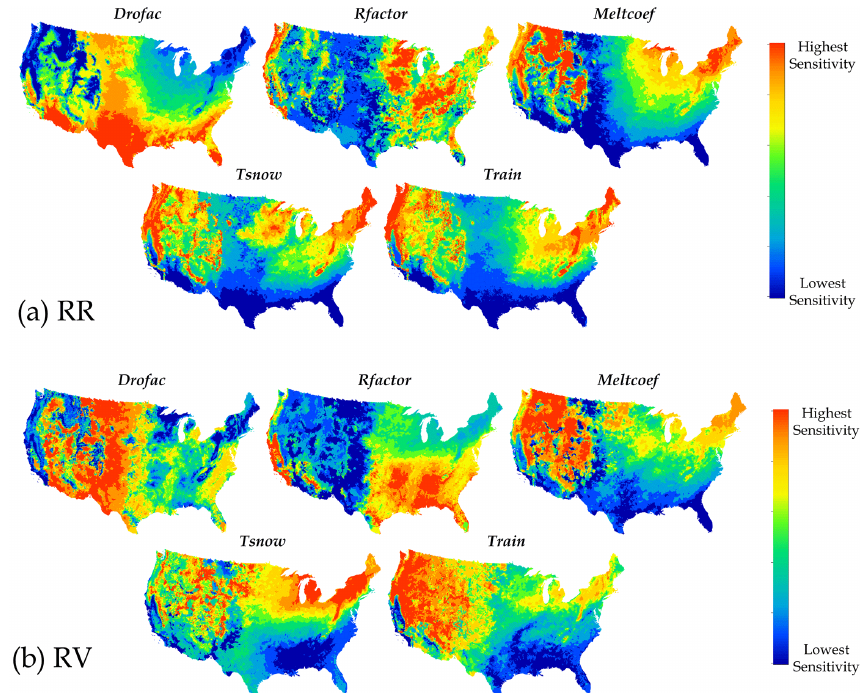
Figure 4. Relative sensitivity of the (a) rainfall ratio (RR) and (b) runoff variability (RV) indices to monthly water balance model parameters.